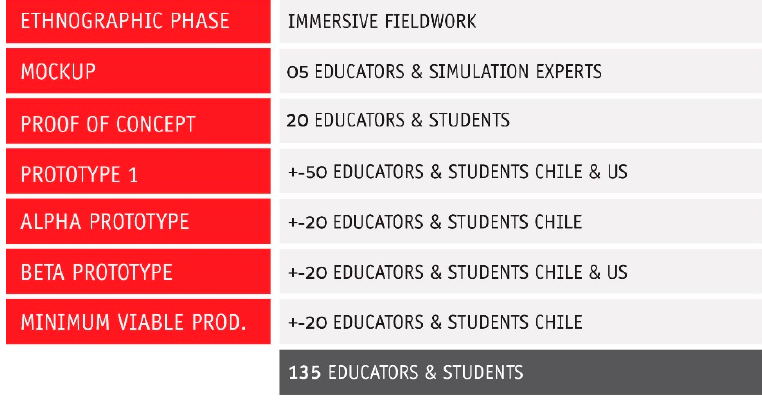
Figure 3. Summary of participants in the testing phases.